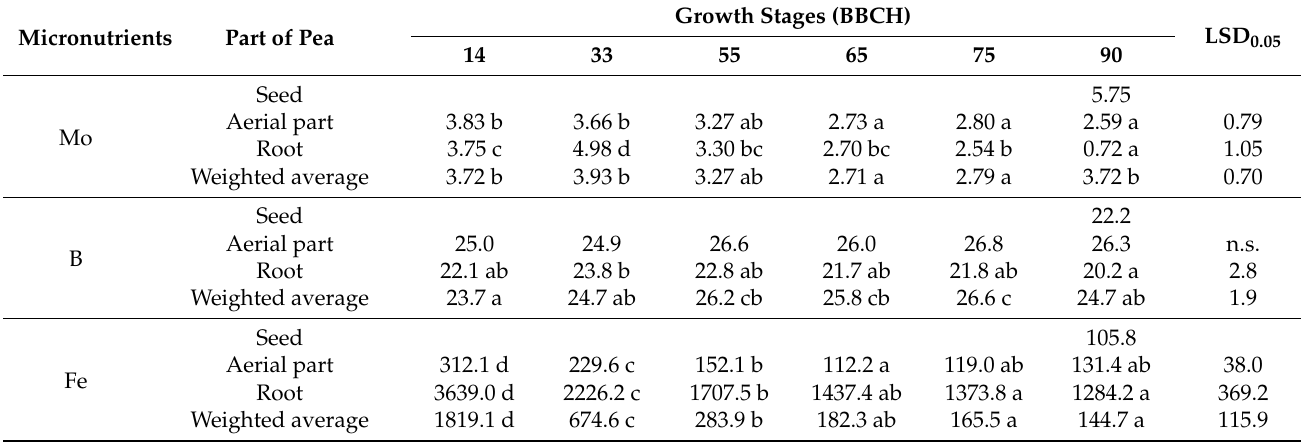
Table 3. Mo, B, and Fe content in dry mass of pea in successive growth stages, mg · kg − 1 DW.